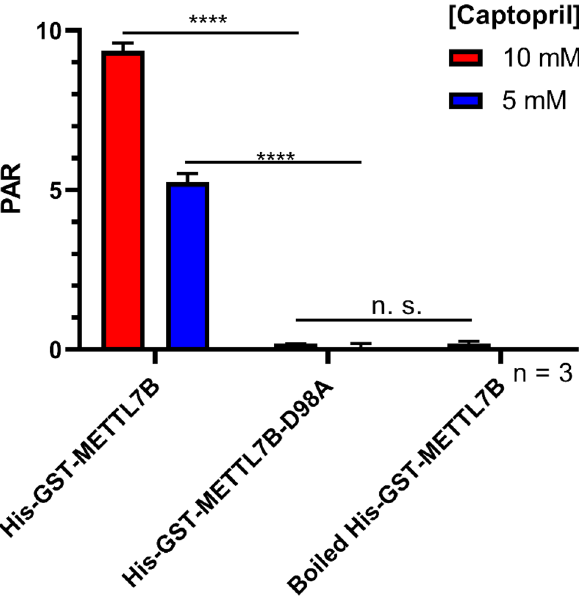
Figure 5. Thiol methyltransferase activity of purified His-GST-METTL7B and His-GST-METTL7B-D98A: Peak area of S -methyl captopril normalized to internal standard (PAR) at two substrate concentrations for both wild-type METTL7B (His-GST-METTL7B) and METTL7B containing a D98A point mutation (His- GST-METTL7B-D98A). Samples were protein-normalized to 0.15 mg/mL via A 280. Data is presented as the